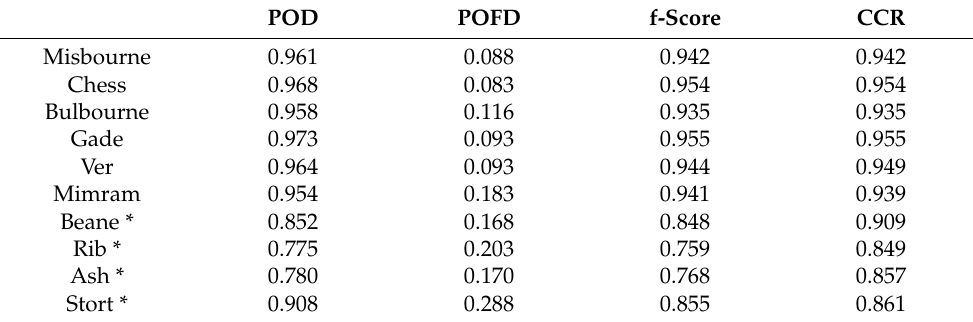
Table 3. Cumulative logit model performance metrics for each river. POD—Probability of Detection, POFD—Probability of False Detection, CCR—Correct Classification Rate. The rivers are ordered west to east. POD POFD